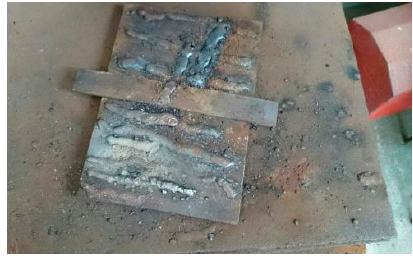
Figure 9. Student’s First Work of Welding.